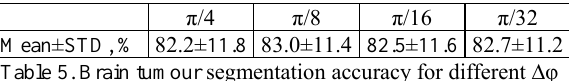
Table 3. Heart segmentation accuracy for different ∆φ (number of rays)